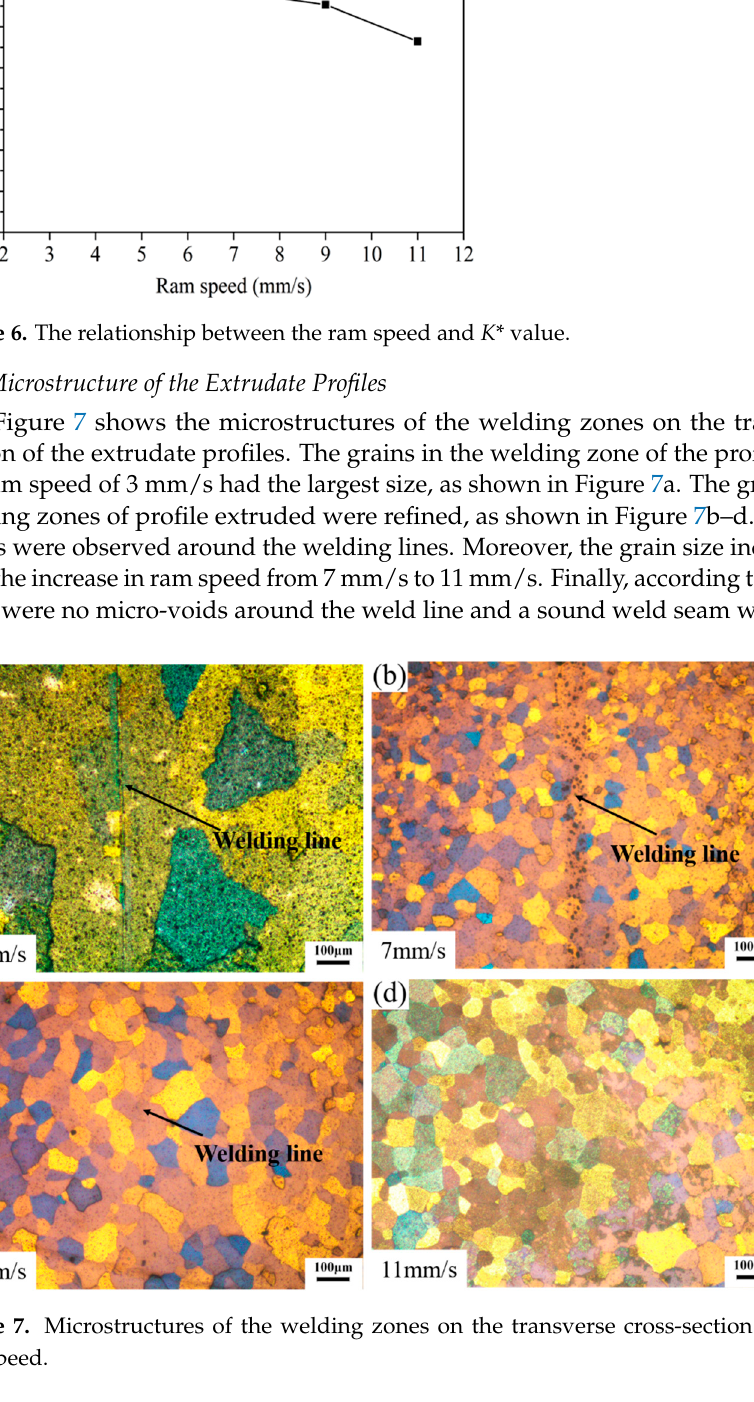
6 of 16 Figure 5. Effective stress distributions on the welding planes. ( a – d ) different ram speed. According to Equation (1), the K values at different ram speeds were calculated. Ac-